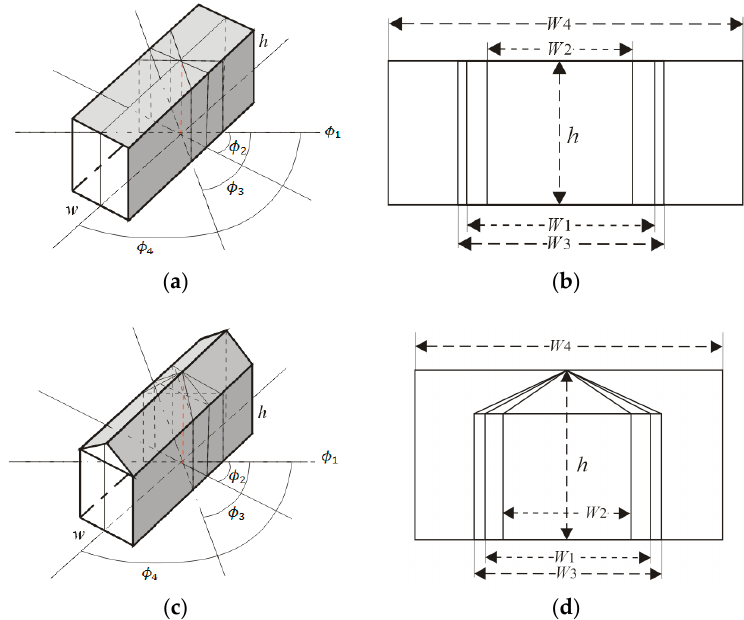
Figure 6. Illustrations of the building profiles of a flat roof building and a gable roof building with different aspect angles. ( a ) A flat roof building model illuminated by radar waves in four directions; ( b ) building profiles corresponding to the four different directions; ( c ) a gable roof building model illuminated by radar waves in four directions; ( d ) building profiles corresponding to the four different directions.